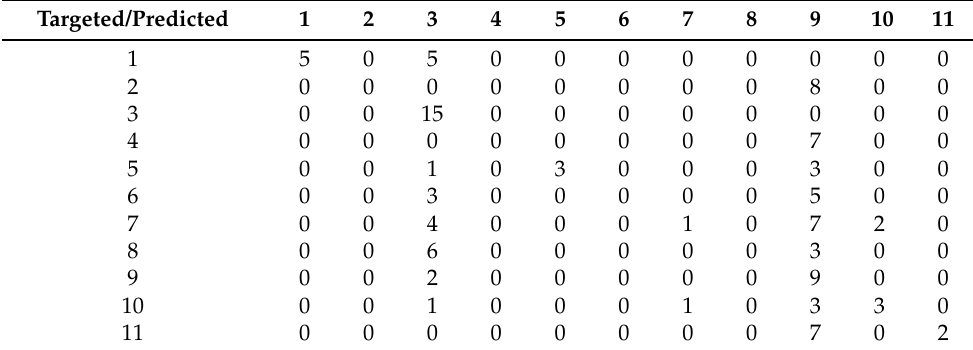
Table 4. The confusion matrix for 3D Resnet50 [21].